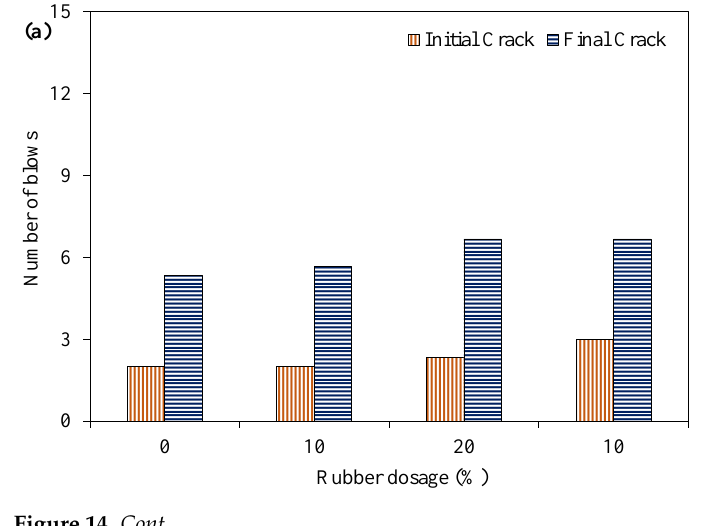
Figure 14. Number of blows for the initial and final cracks under the impact load for various dosages of rubber: ( a ) R1, ( b ) R5, ( c ) R10.